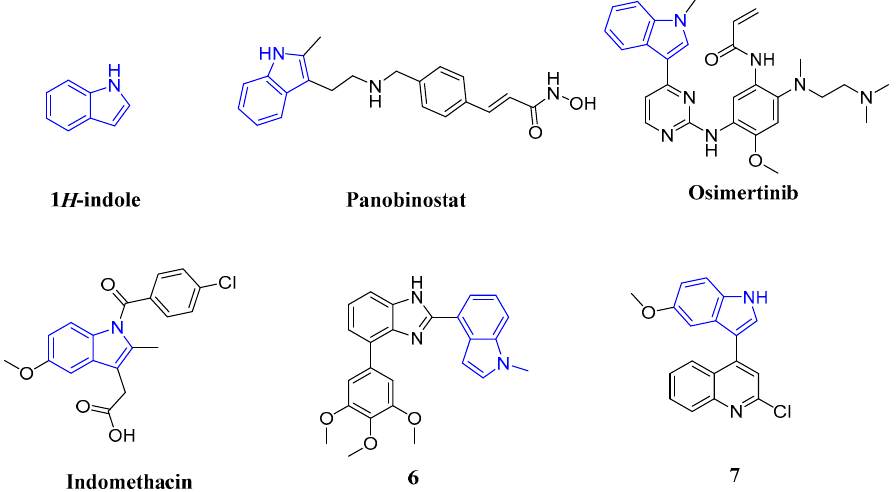
Figure 2. Structures of indole and its previously reported derivates.